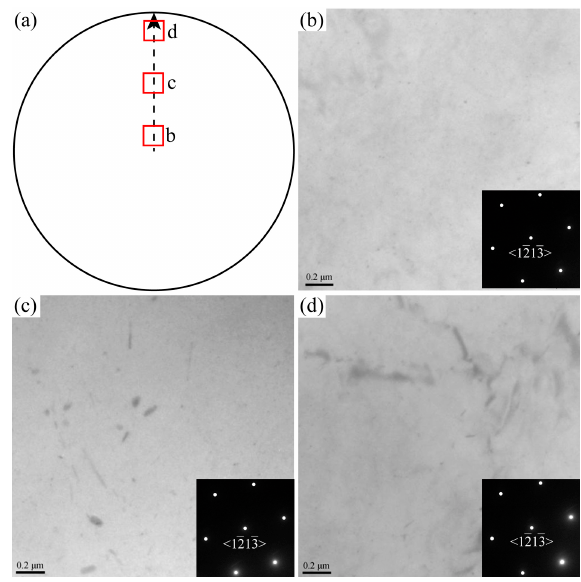
< > < > direction: ( a ) schematic direction: ( a ) schematic